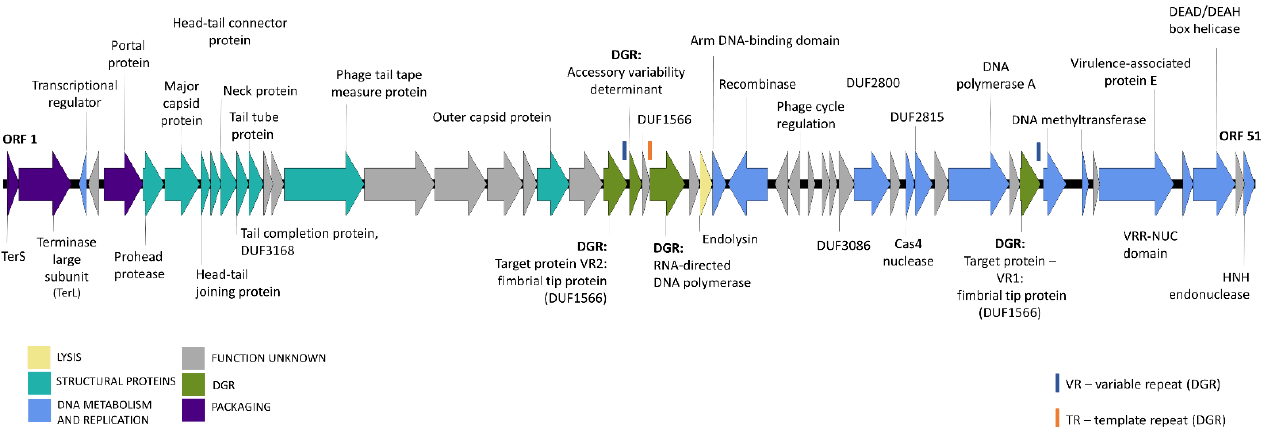
Figure 2. Linear genome map of Bacuni phage F1. Colors of open reading frames correspond to the general predicted functions (see color legend for details). Genes with no functional annotations (hypothetical proteins) are not labeled. Locations of template sequence (TR) and variable repeats (VR) of diversity-generating retroelement (DGR) are marked with orange and red rectangles above associated proteins. The position of ORF 1 was chosen arbitrarily and is not meant to imply the position of natural phage genome